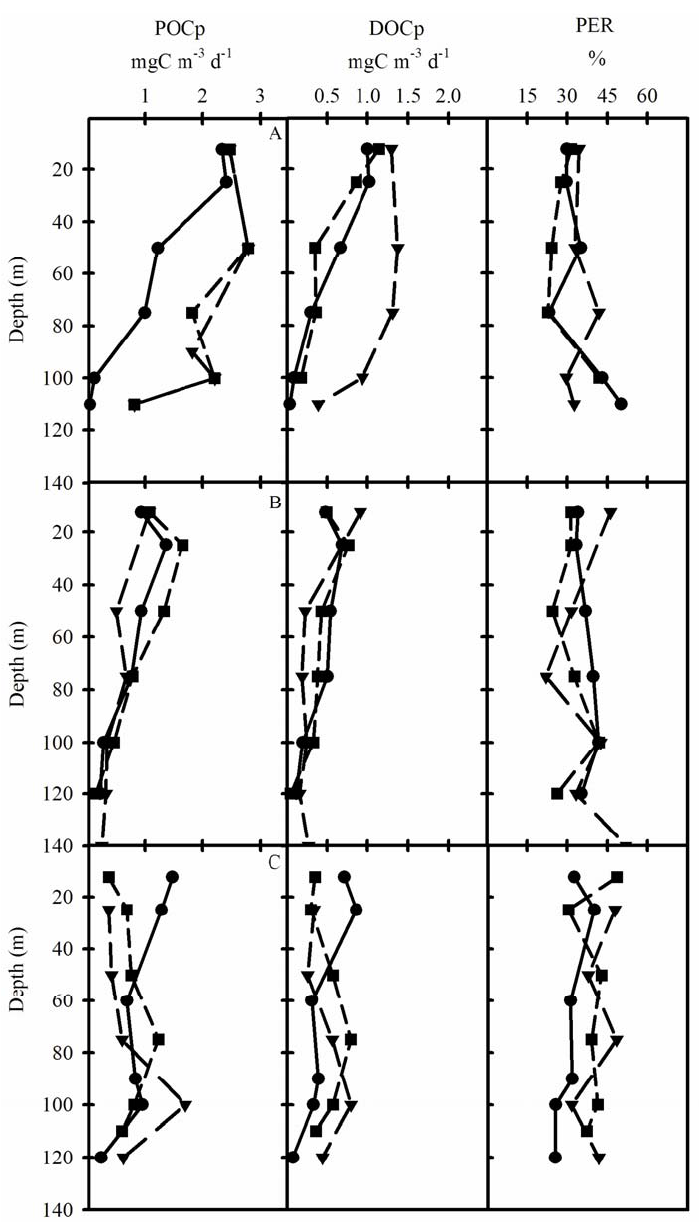
Figure 3. Vertical profiles of DOCp, POCp (mgC m -3 h -1 ), and PER from the stations sampled at Fig. 3. Vertical profiles of DOCp, POCp (mgCm − 3 h − 1 ) , and PER from the stations sampled at regions A (Algero Provenc¸al eddy), B regions A (Algero Provençal eddy), B (Ionian eddy) and C (Levantine eddy). (Ionian eddy) and C (Levantine